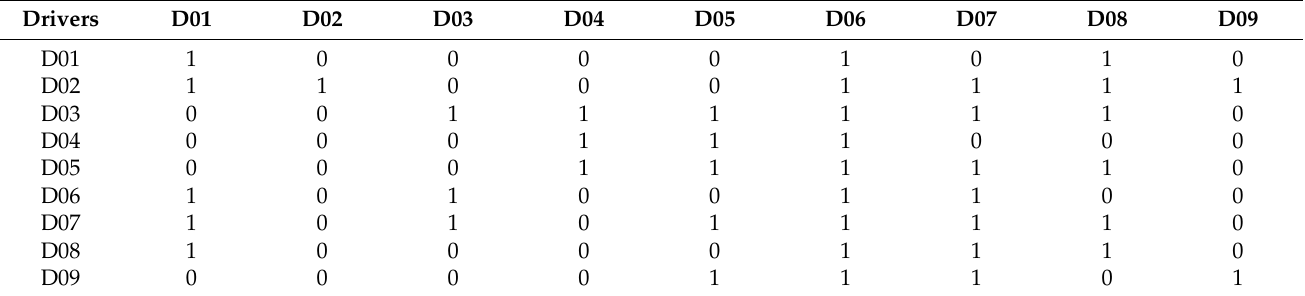
Table 3. Initial reachability matrix.